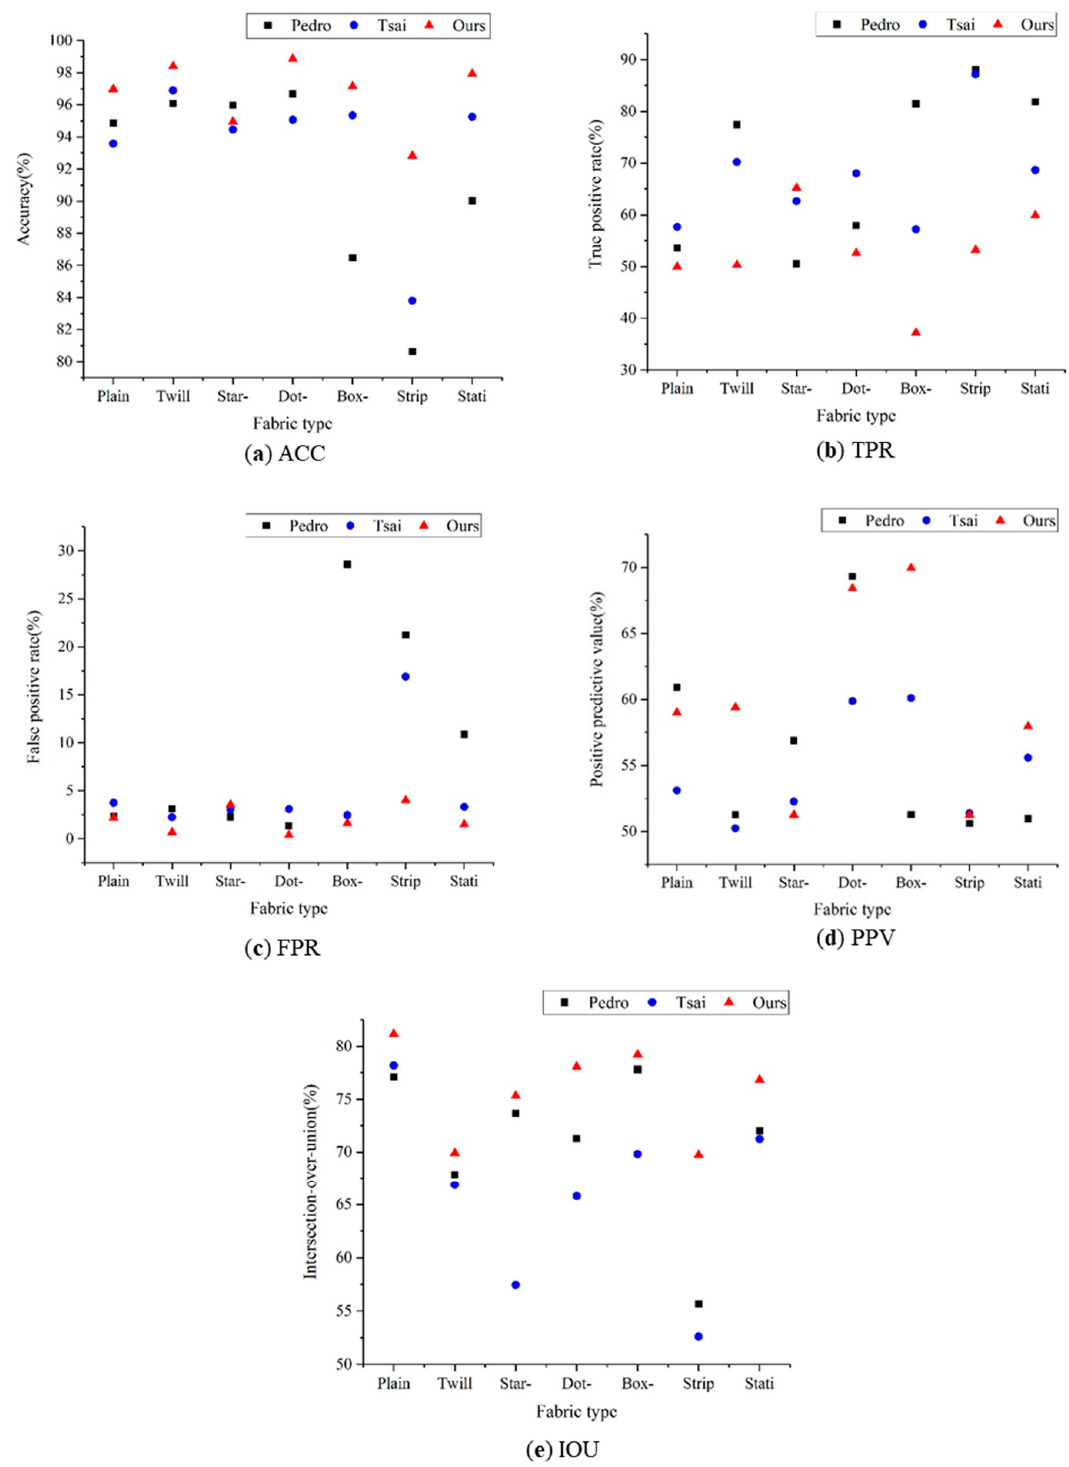
Figure 18. Inspection results of defect inspection methods with different methods on different types of fabric.